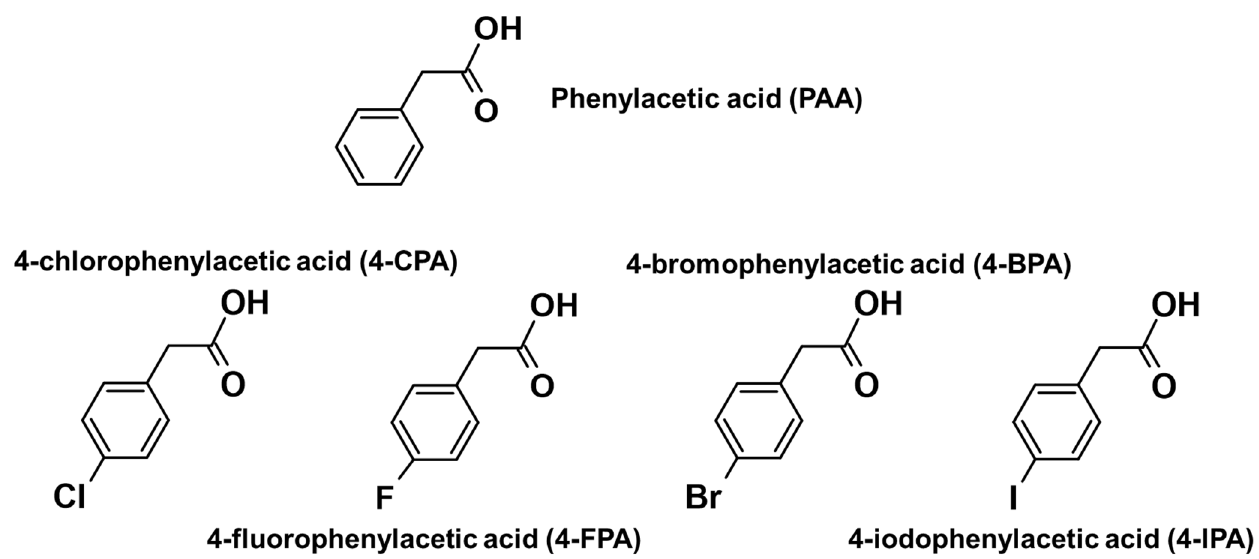
Figure 5. Structures of PAA and its halogenated derivatives.